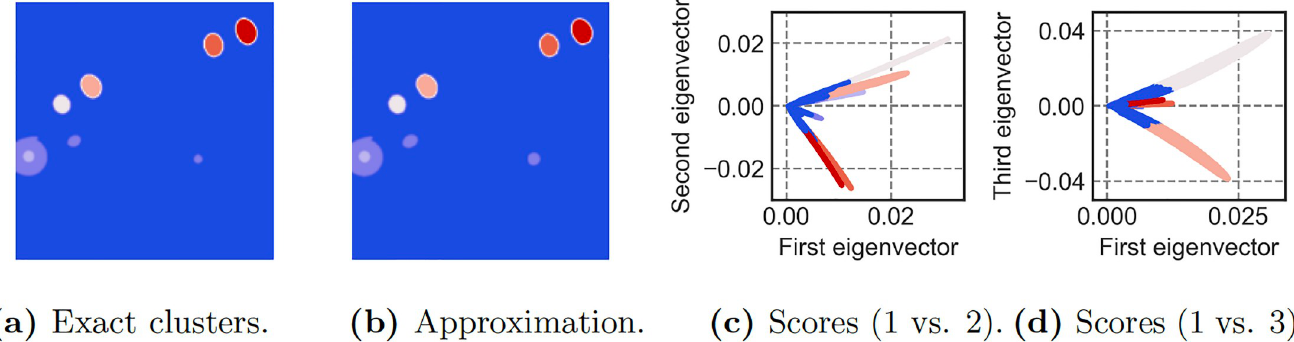
Fig 9. Spectral clustering using the top three eigenvectors of the adjacency matrix for the airfoil wake flow. In (a) we show the clusters that we found using the exact eigenvectors. It can be seen that the approximate eigenvectors allow us to reveal the same seven clusters, as shown in (b). In (c) and (d) we show the first three approximated eigenvector coordinates to visualize the clusters and